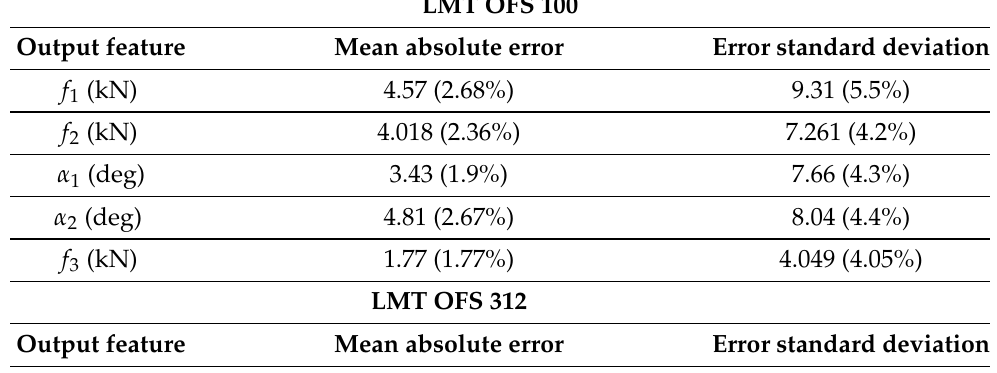
Table 7. Output error analysis for the three different LMTs LMT OFS 100, LMT OFS 312, and LMT 467. The improvements from the LMT presented in [27] are highlighted in red. LMT OFS